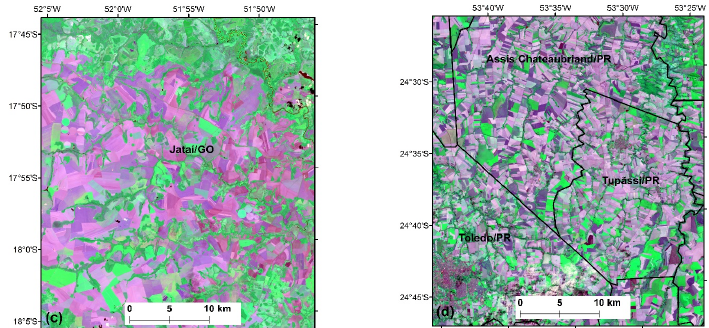
Figure 2. RBG color composites of Landsat-8 scenes (bands 4, 5, and 6; year = 2015) from the following representative sites of Brazil in terms of large-scale grain production: ( a ) municipality of Formosa do Rio Preto, Bahia State, Northeast region; ( b ) municipality of Sorriso, Mato Grosso State, Midwest region; ( c ) municipalities from Jataí/GO; and ( d ) municipality of Assis Chateaubriand, Paraná State and surroundings.